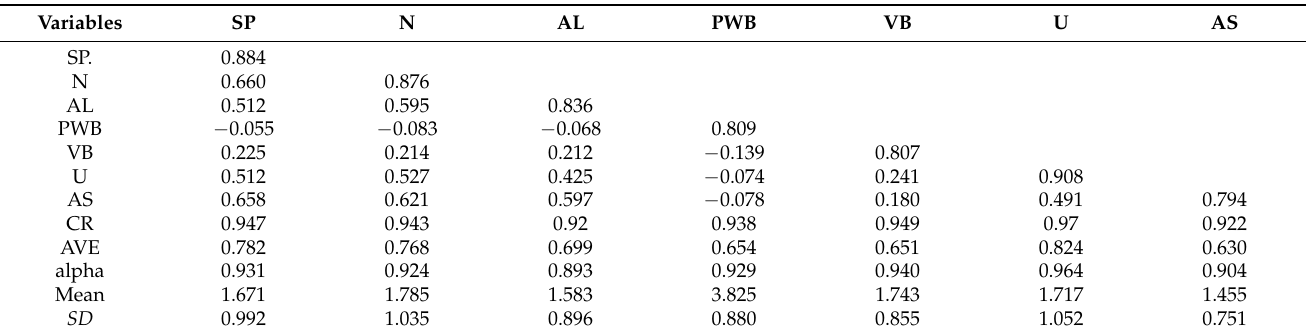
Table 1. Discriminant validity, composite scale reliability (CR), average variance extracted (AVE), Cronbach alpha values and descriptive